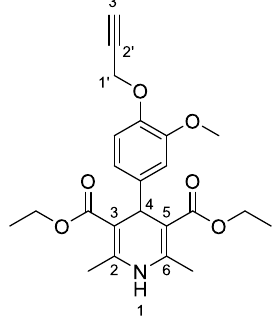
Figure 5. Chemical stucture of 3d .